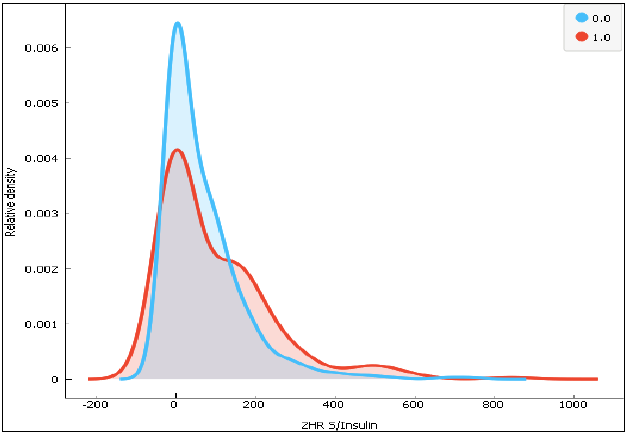
Figure 8. The distribution of 2-h Serum insulin for the two classes (0-diabetes and 1-non-diabetes).